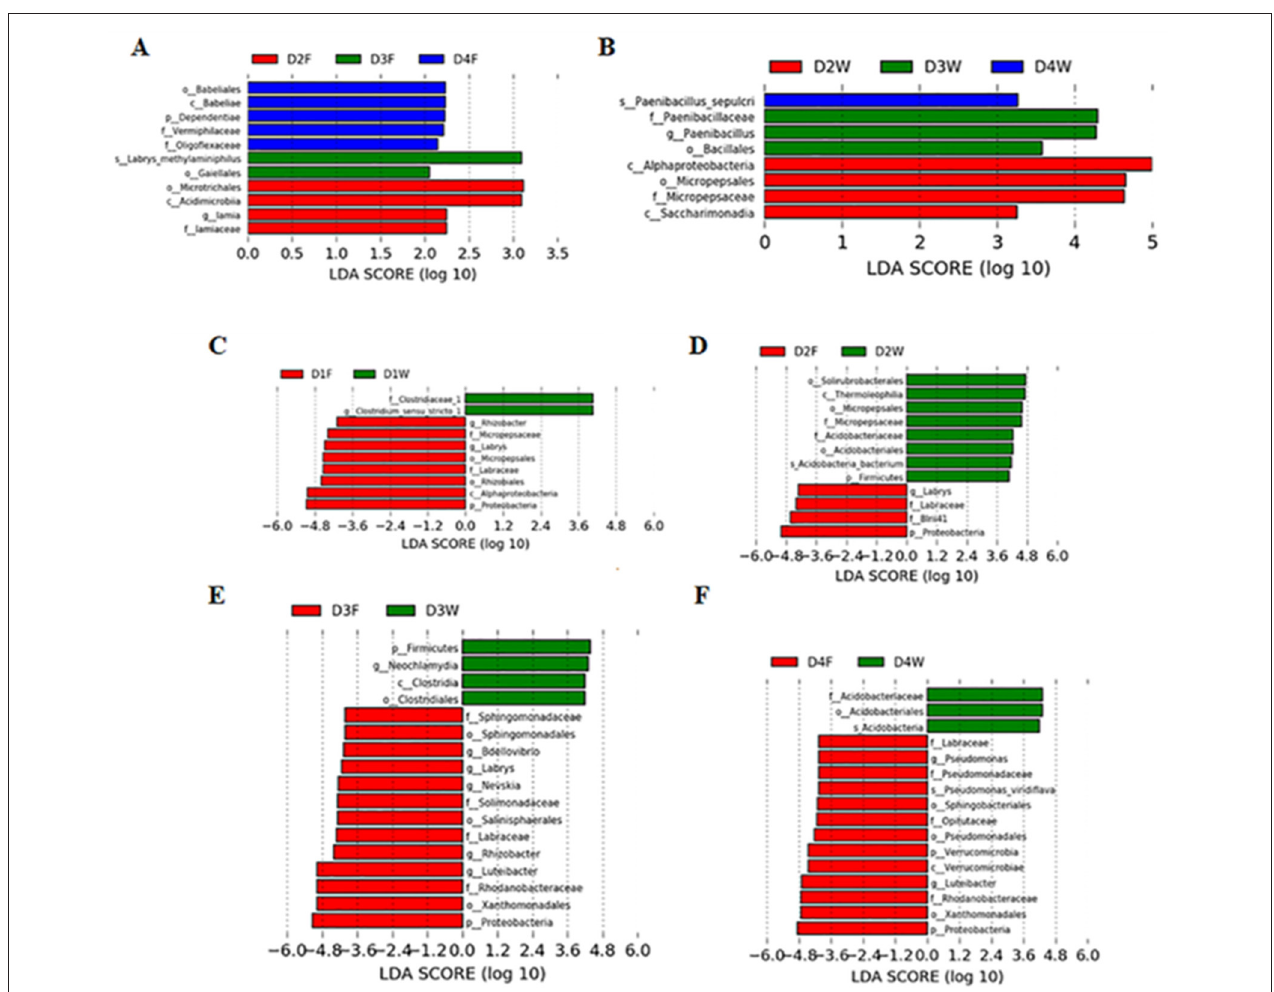
FIGURE 5 | Linear discriminant analysis (LDA) effect size (LEfSe) showing bacterial phyla, class, order, family, genus, and species, which were significantly different in (A) fruiting body, (B) wood under different decay classes, and between fruiting body and wood in the same decay class, (C) class 1, (D) class 2, (E) class 3, and (F) class 4. p, phylum; c, class; o, order; f, family; g, genus; s,